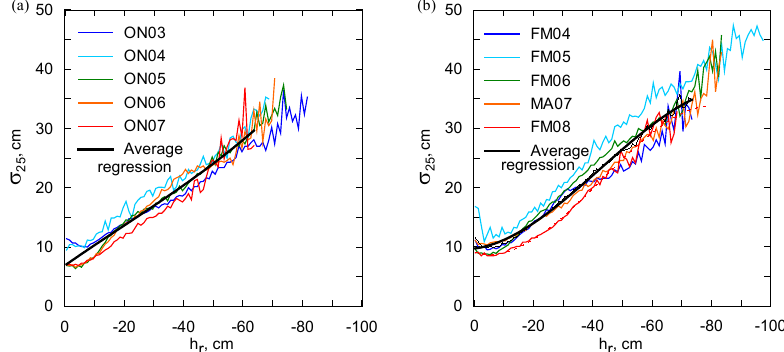
Figure 5. The relationships between h r and σ 25 , for samples where dip in reflectivity is measured for fall (a) and winter (b) ICESat periods, following the method described in Kwok et al. (2007). The h r axis is discretized in bins of 1cm. Note that following Zwally et al. (2008) and Yi and Zwally (2009) we define h r as h r = h − ¯ h and form the relationship for negative h r values, while in Kwok et al. (2007) h r = ¯ h − h and positive h r values are